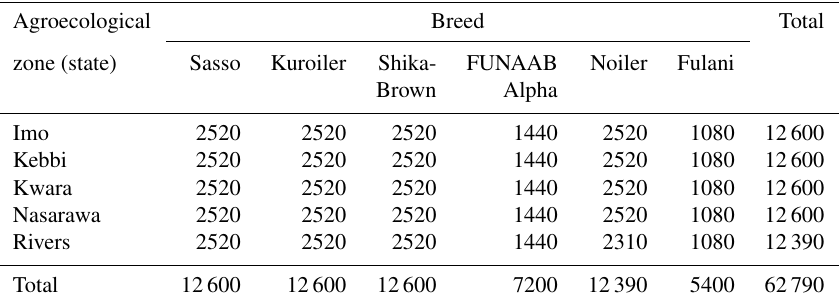
Table 1. The number of chicken breeds distributed based on agroecological zones. Agroecological Breed Total zone (state) Sasso Kuroiler Shika- FUNAAB Noiler Fulani Brown Alpha Imo 2520 2520 2520 1440 2520 1080 12600 Kebbi 2520 2520 2520 1440 2520 1080 12600 Kwara 2520 2520 2520 1440 2520 1080 12600 Nasarawa 2520 2520 2520 1440 2520 1080 12600 Rivers 2520 2520 2520 1440 2310 1080 12390 Total 12600 12600 12600